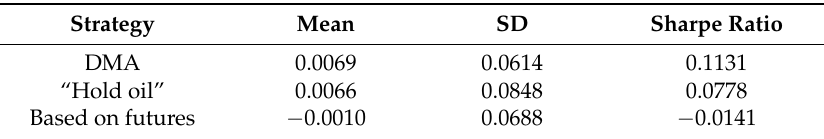
Table 6. Comparison of investment